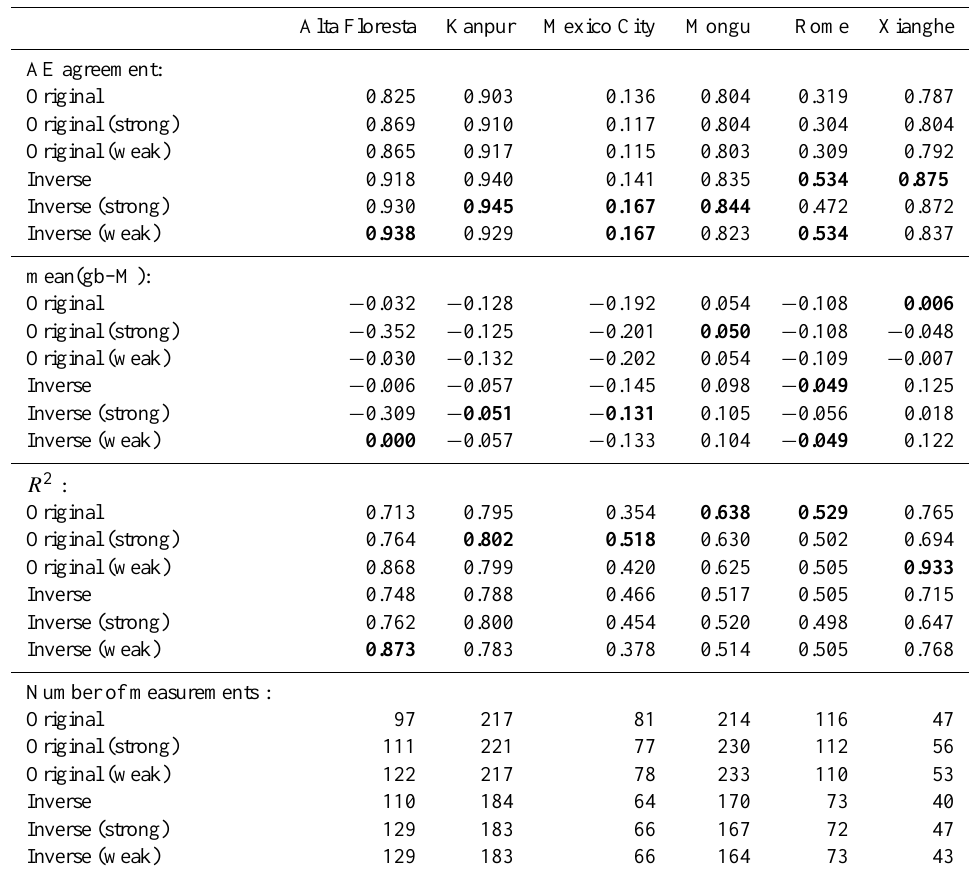
Table 3. Comparison of the AE and AOD agreement parameters from the original retrieval (Original), and the retrieval with the inverse NDVI-slope relationship (Inverse) at 6 sites. In addition, retrievals where aerosol models were assigned to be either strongly absorbing (strong, SSA 550nm =0.86) or weakly absorbing (weak, SSA 550nm =0.95) are presented for both classes. AE agreement refers to the fraction of AE agreement while mean(gb–M) is the averaged AOD difference between the instruments (AERONET–MODIS). R 2 is the correlation coefficient for AOD. These values are also presented in Fig. 6. The best values for each of the parameters are shown in bold. In addition, the number of measurements used in the comparisons are